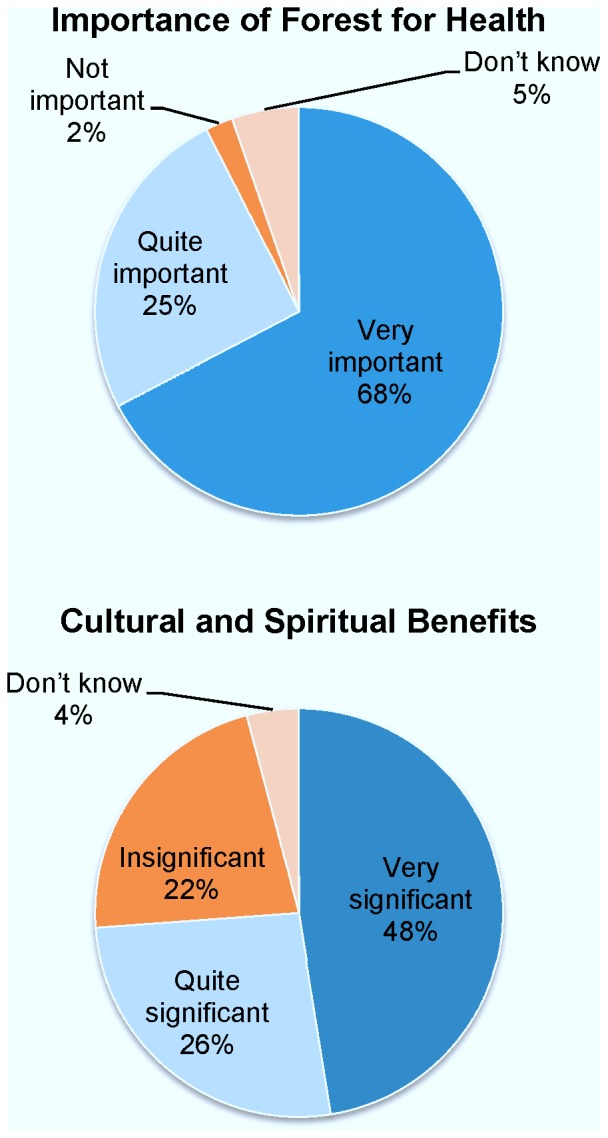
Perceptions on the Importance of Forest for Health and for Cultural and Spiritual Benefits expressed as percentages of the total of respondents’ answers.(a) Importance of Forest for Health. (b) Cultural and Spiritual Benefits. Analyses are based on the full data set.